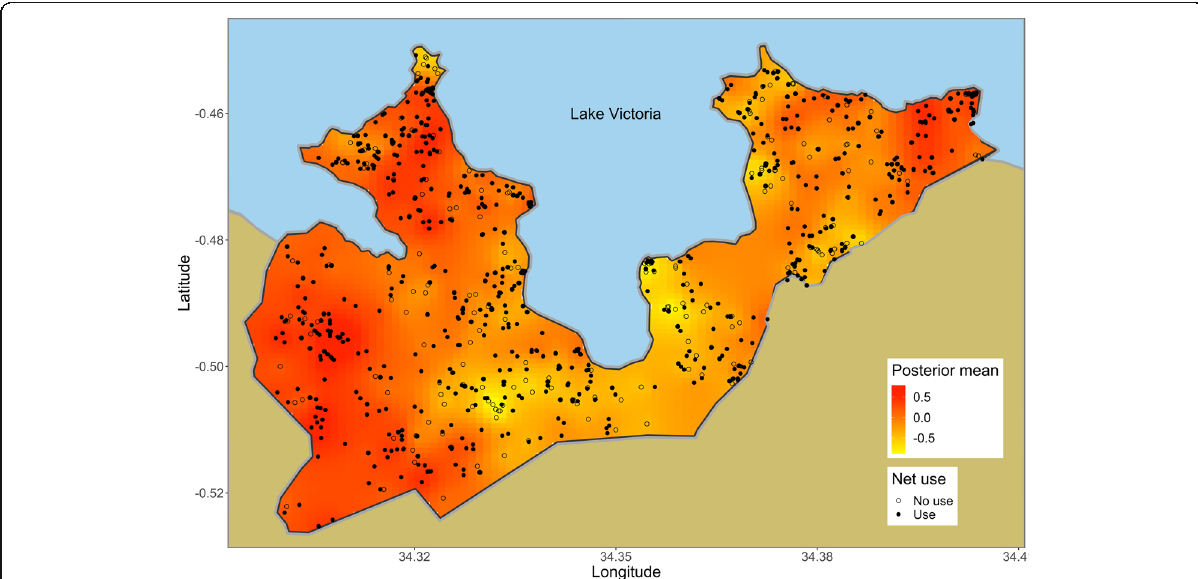
Fig. 4 The interpolated spatial pattern of net use. The map was generated with posterior mean values of spatial random field obtained from the Bayesian regression